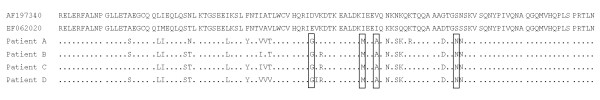
Gag p17/p24 junction amino acid alignment. Amino acid sequences of Patient A - D was aligned and compared with NCBI CRF01_AE reference sequence (Accession number: AF197340) and the highest homology matched sequence detected in Yunnan China in 2002 (Accession number: EF062020). Dots indicate identical amino acid residue. Boxed regions indicate cluster-specific amino acid alterations (frequency = 100%) with respect to AF197340 and EF062020.